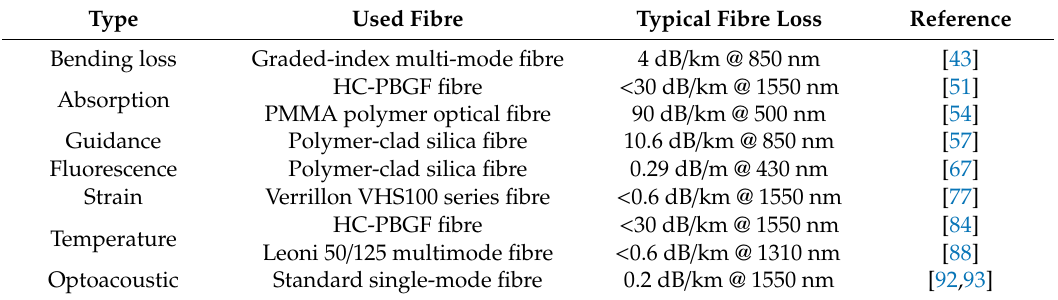
Table 2. Fibre loss for di ff erent reported distributed chemical sensors.